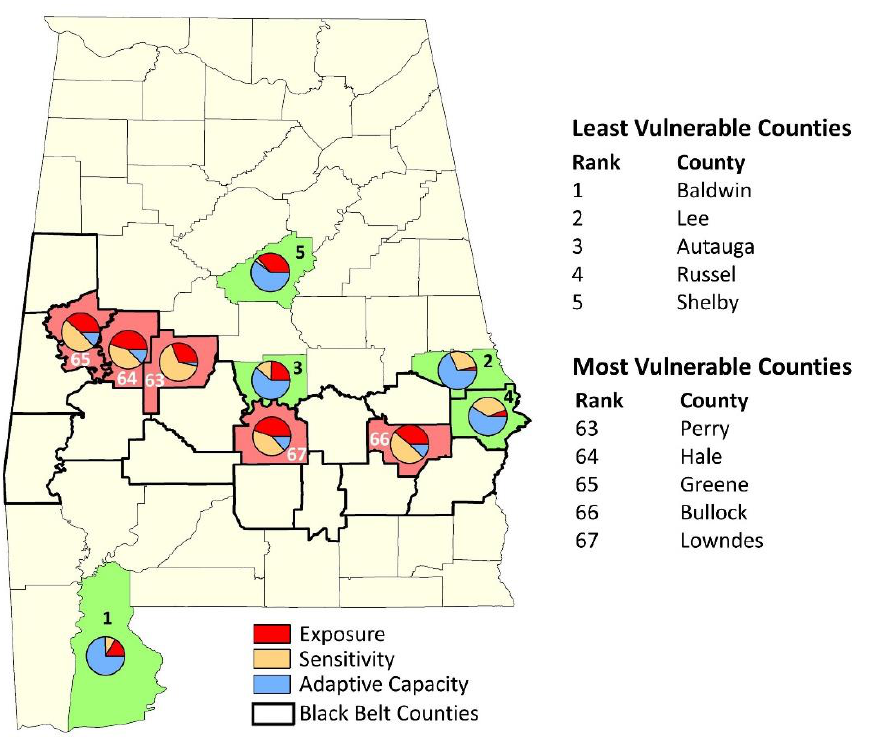
Figure 10. Percent contribution of each subindex to the overall composite index for the five least and most vulnerable counties.